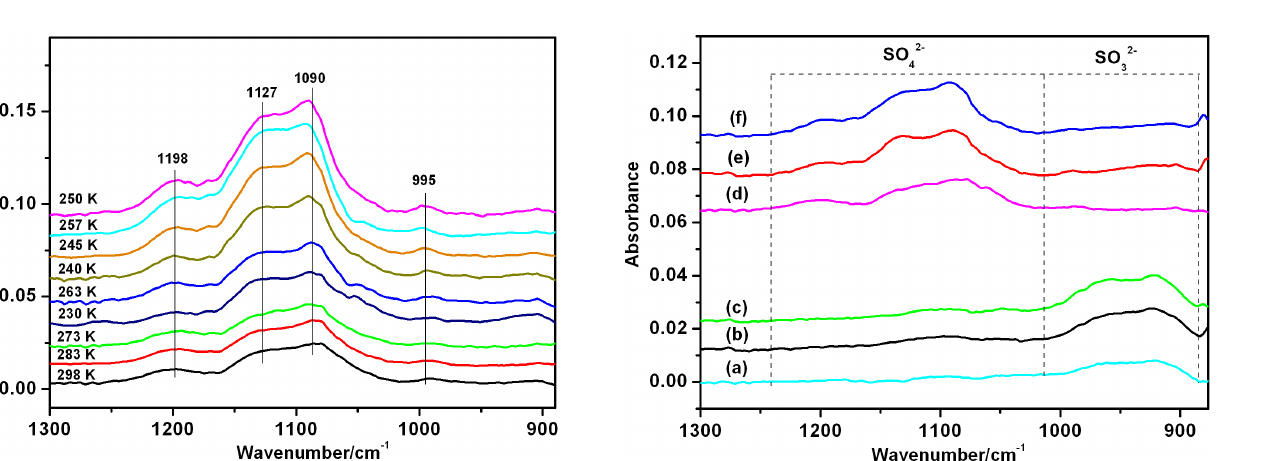
Fig. 2. In situ DRIFTS spectra of surface products when CaCO 3 particles were exposed sequentially to SO 2 (4.9 × 10 14 moleculescm − 3 ) and O 3 (4.9 × 10 14 moleculescm − 3 ) . (a) , (b) , (c) showed the product spectra when the adsorption rate becomes stable after addition of SO 2 at 298K, 263K and 250K, respectively. (d) , (e) , (f) show the product spectra when the SO 2 flow was cut off, and O 3 was introduced into the reaction system for 60 min at 298K, 263K and 250K,